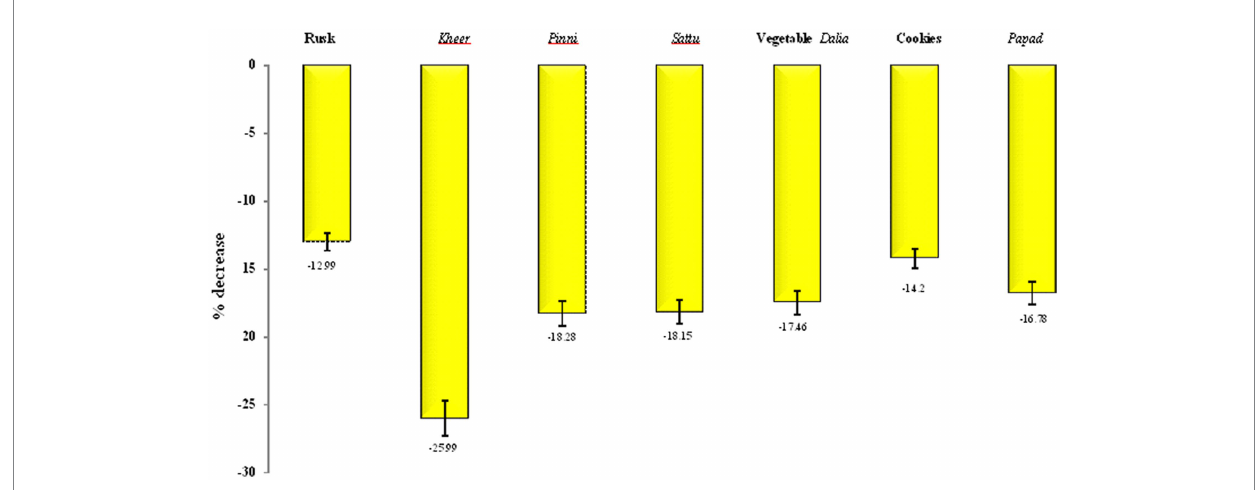
FIGURE 4 Percent decrease in the predicted glycemic index of the food products prepared from Foxtail millet with respect to control group.